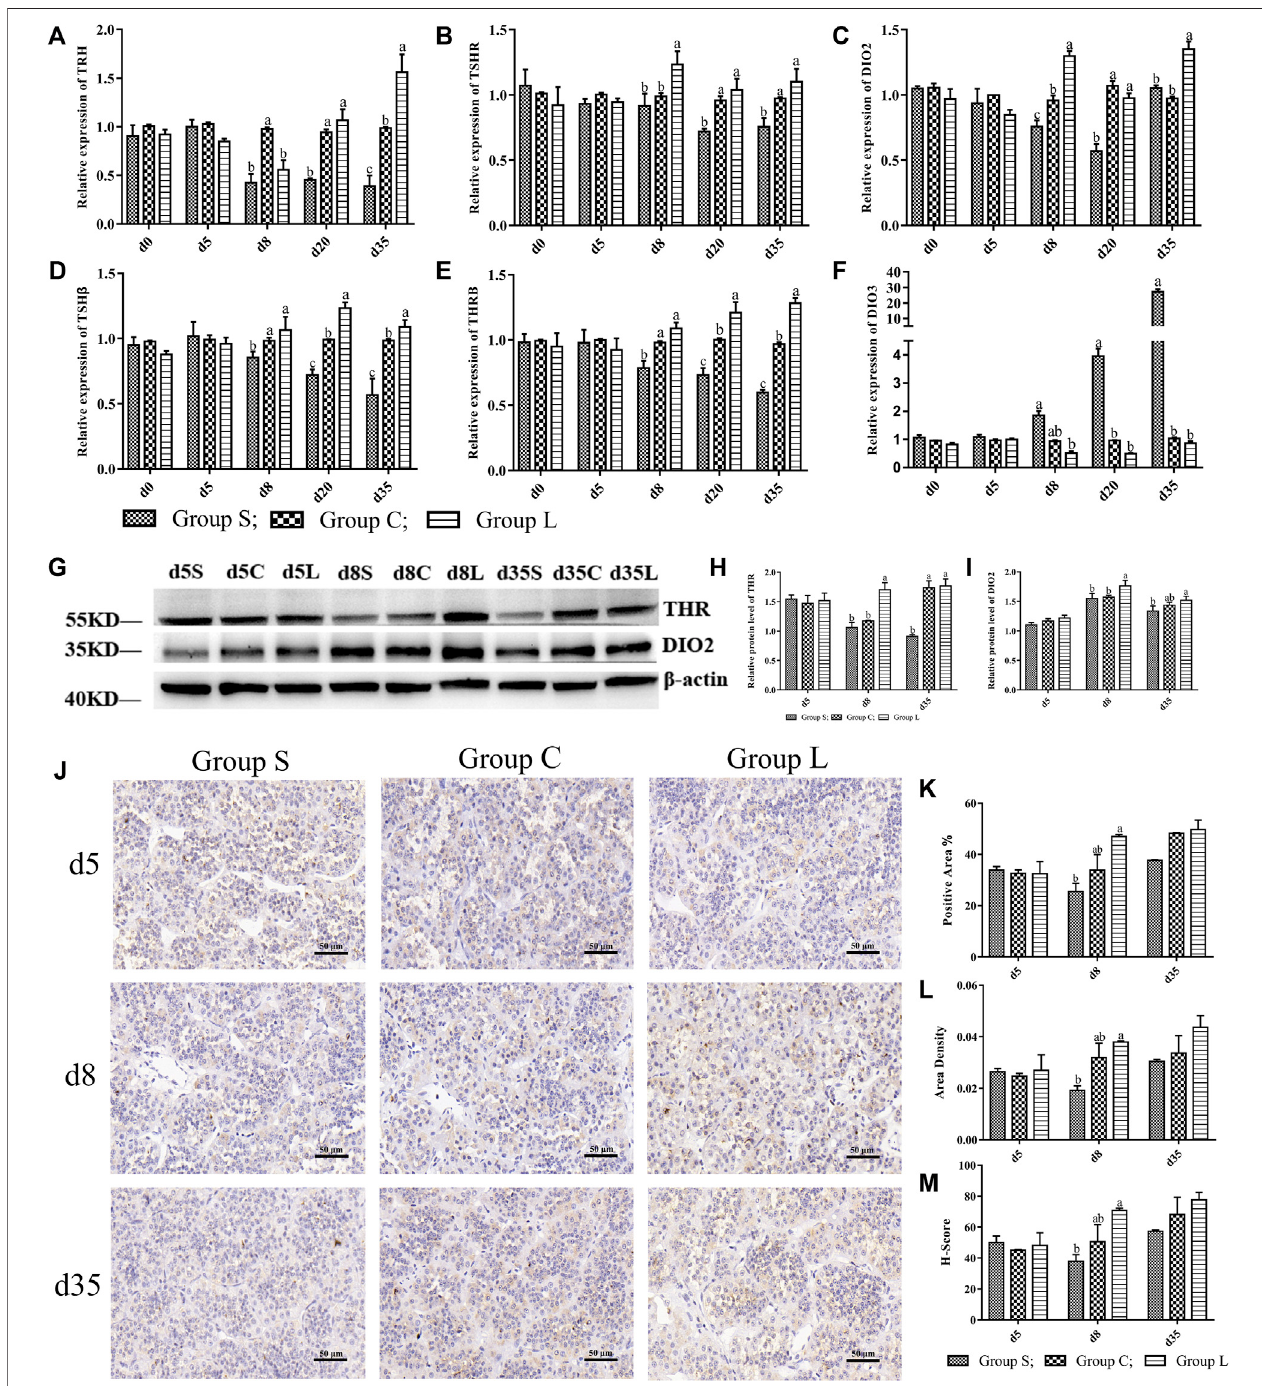
FIGURE5| ExpressionlevelsofgenesandproteinsinTSH-DIO2/DIO3pathwayunderdifferentphotoperiodsExpressionofgenesandproteinsrelatedtotheTSH- DIO2/DIO3 pathway. (A – F) indicated the gene expression levels of TRH, TSHR, DIO2, TSH β , THR β , and DIO3, respectively; (G) , Western Blot results of relative protein levels ofTHR and DIO2; (H) and (I) ,changes inthe protein expression ofTHR and DIO2; (J) , the results of immunohistochemical staining images of TSH (400 × ); (K – M) were the results of TSH immunohistochemical quanti fi cation, indicating the results of positive area, Area density, H-Score, respectively.